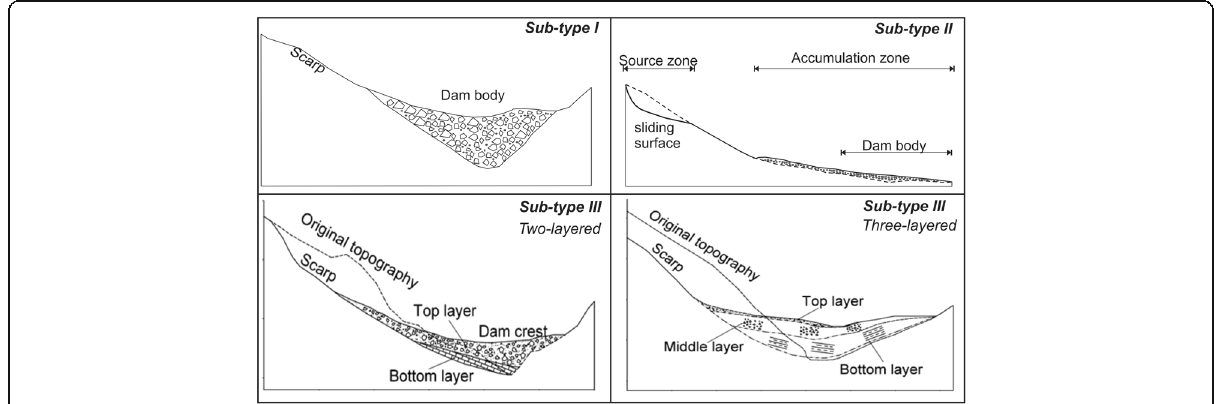
Fig. 14 Three sub-types based on dam composition material and sedimentological